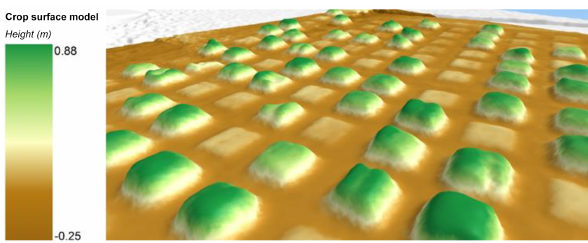
Figure 3. Visual three-dimensional representation of the crop sur- face model (CSM), upon differencing of the original digital surface model (DSM) and a secondary model approximating the ground surface digital elevation model (DEM) of the study area. Vegeta- tion height is illustrated from low to high by change in colour from brown to